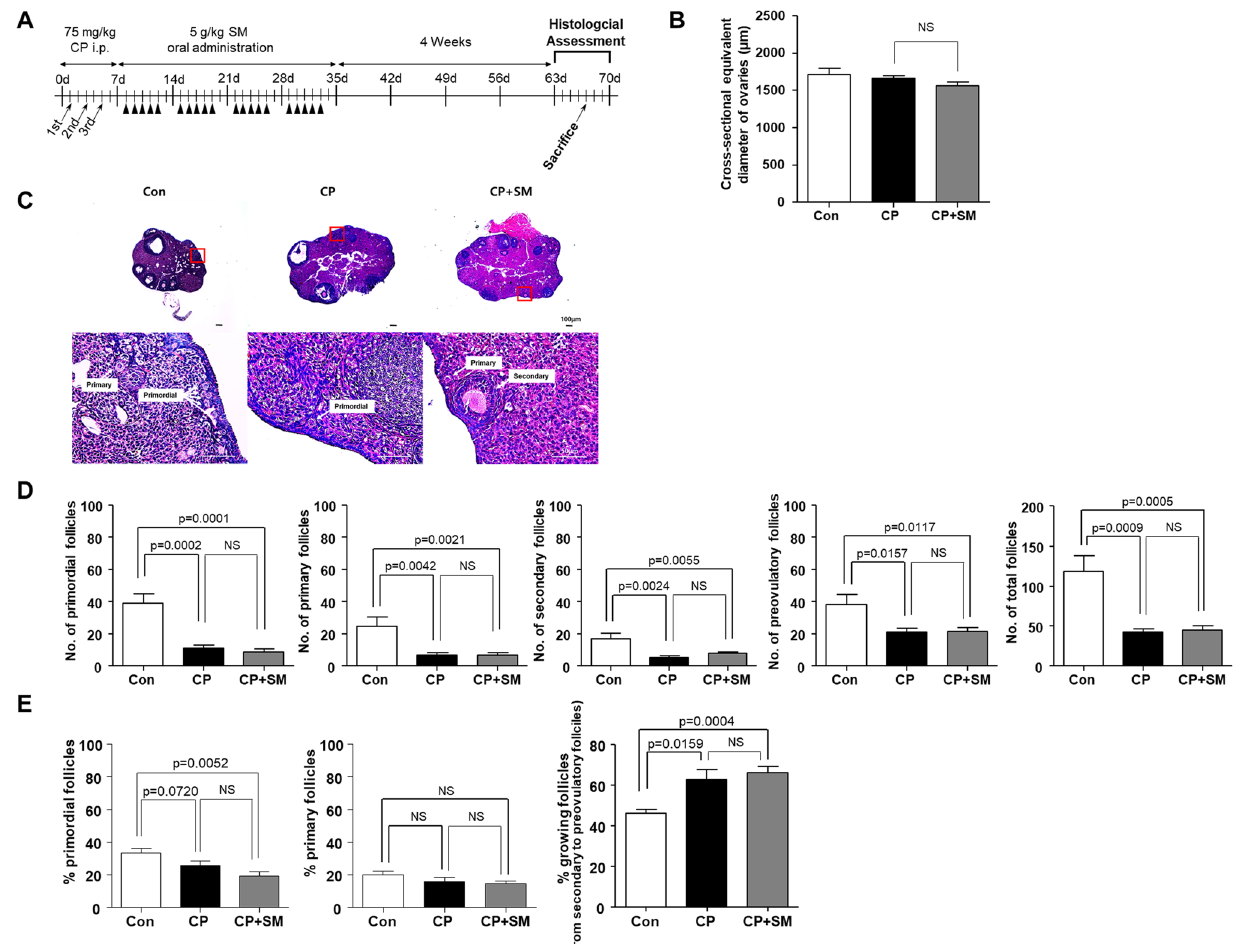
Figure 2. Histological analysis of ovarian follicles in mice at 4 weeks after Samul-tang (SM) administration. ( A ) Mice were intraperitoneally injected with saline (n = 4, Con group) or cyclophosphamide (CP) on days 1, 3, and 5 in the first week; mice injected with CP were then orally administered distilled water (n = 4, CP group) or 5 g/kg SM (n = 5, CP + SM group) five times a week for 4 weeks. Four weeks after SM administration, ovaries from all three groups were assessed histologically. ( B ) Cross-sectional equivalent diameter of the ovaries. ( C ) Representative histological images of ovaries from mice in the three experimental groups. ( D ) Numbers of ovarian follicles in different stages and the total number of ovarian follicles; and ( E ) proportions of primordial, primary, and growing (secondary and preovulatory) follicles in the Con, CP, and CP + SM mice. Statistical analysis was performed using the Student’s t -test. Arrows and arrowheads indicate the days of CP injection and SM administration, respectively. NS not